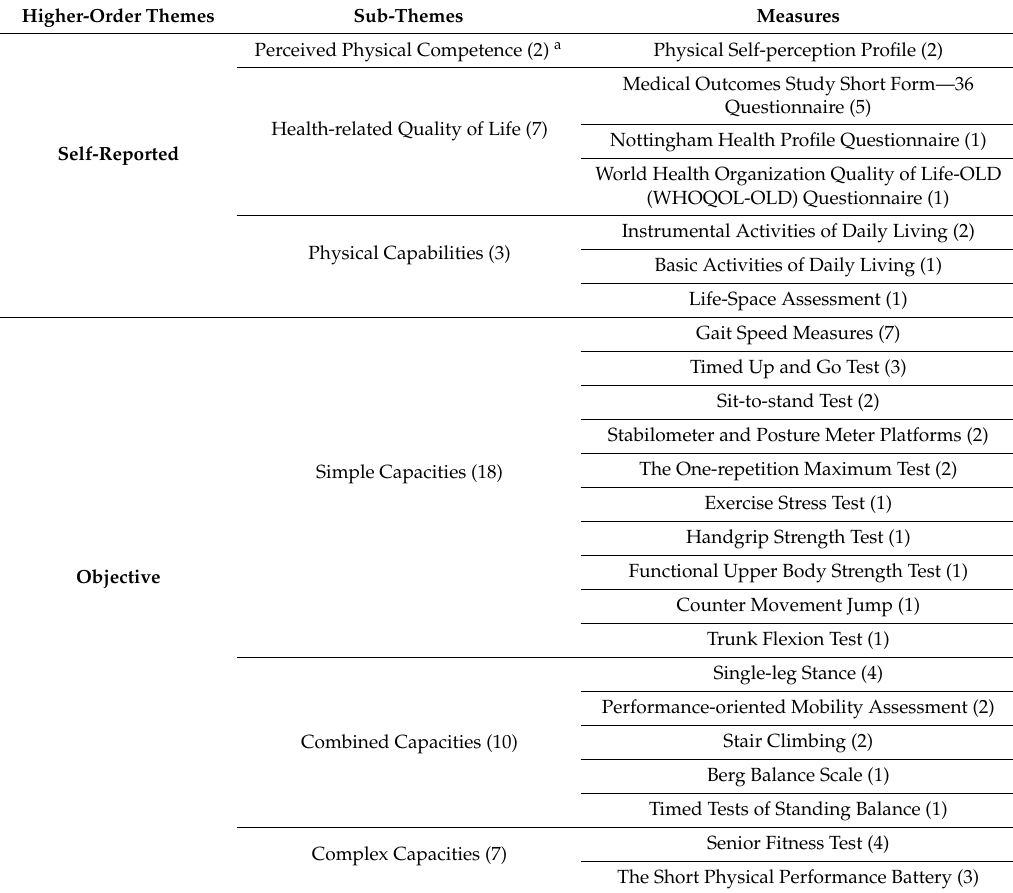
Table 1. Thematic analysis of the measures of physical competence within physical literacy for older